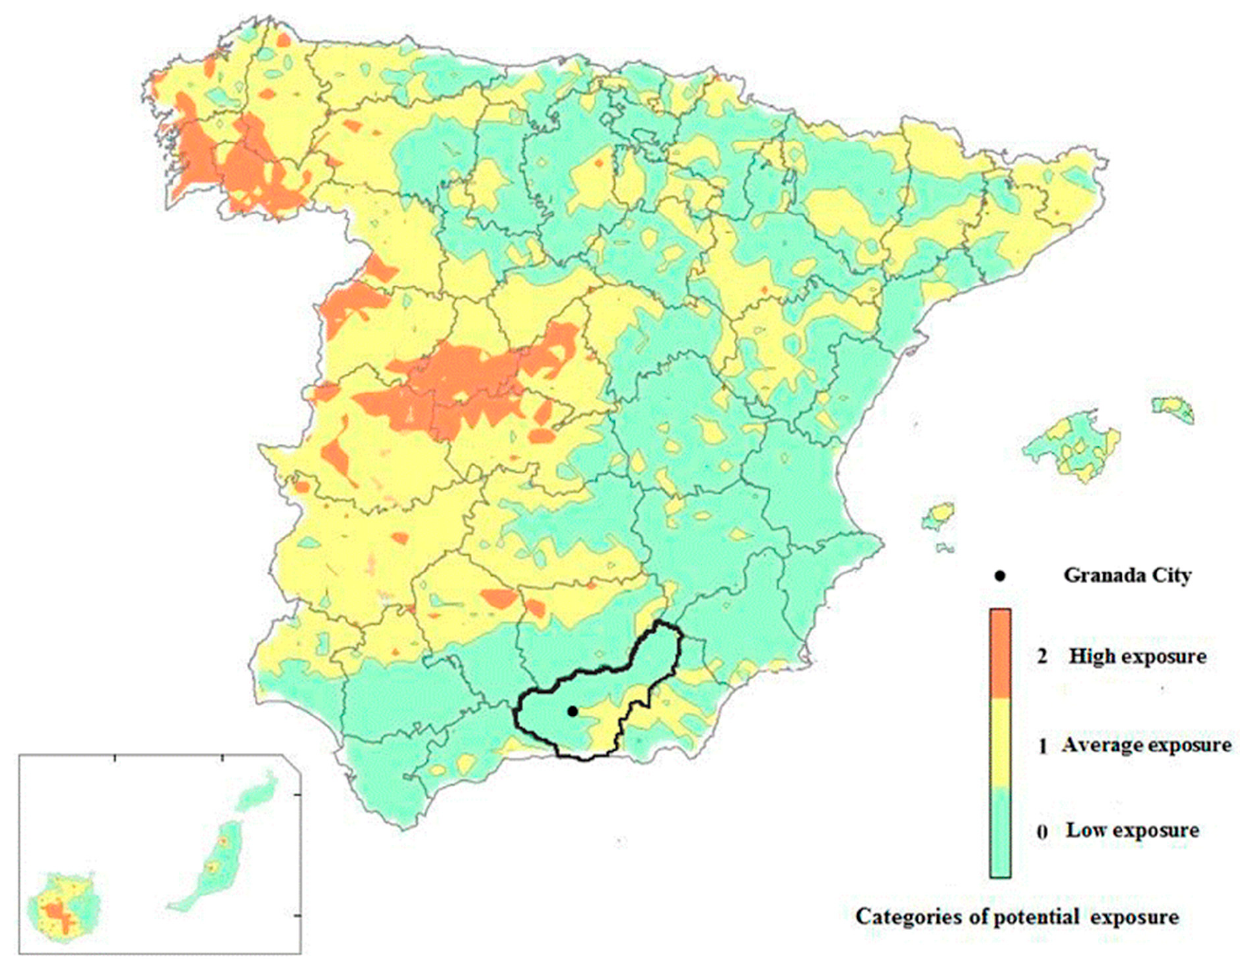
Figure 4. Map of exposure to radon-CSN (Spanish Nuclear Safety Council). The province of Granada is demarcated with a black line, and the capital (Granada) is indicated with a black dot. http://www.csn.es/en/mapa-de-exposicion-al-radon- en-espana (accessed on 22 April 2019).